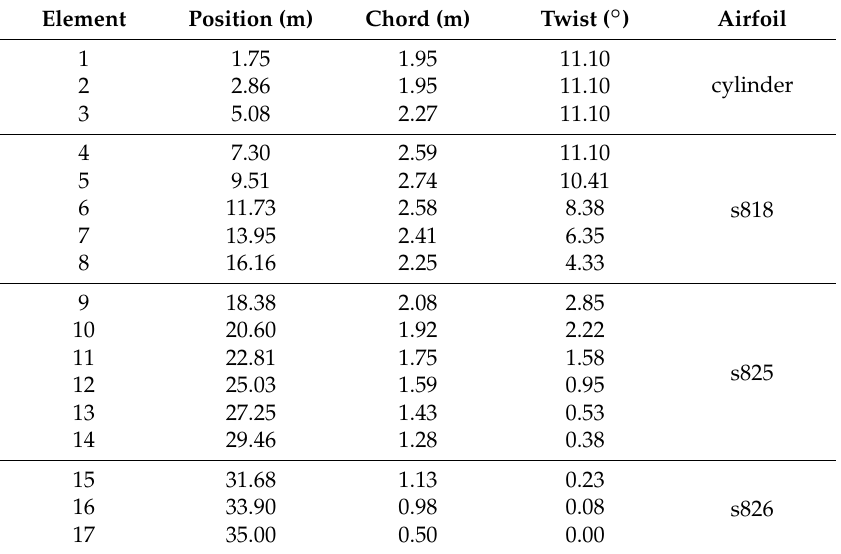
Table 2. Geometry of the NREL 1.5 MW wind turbine